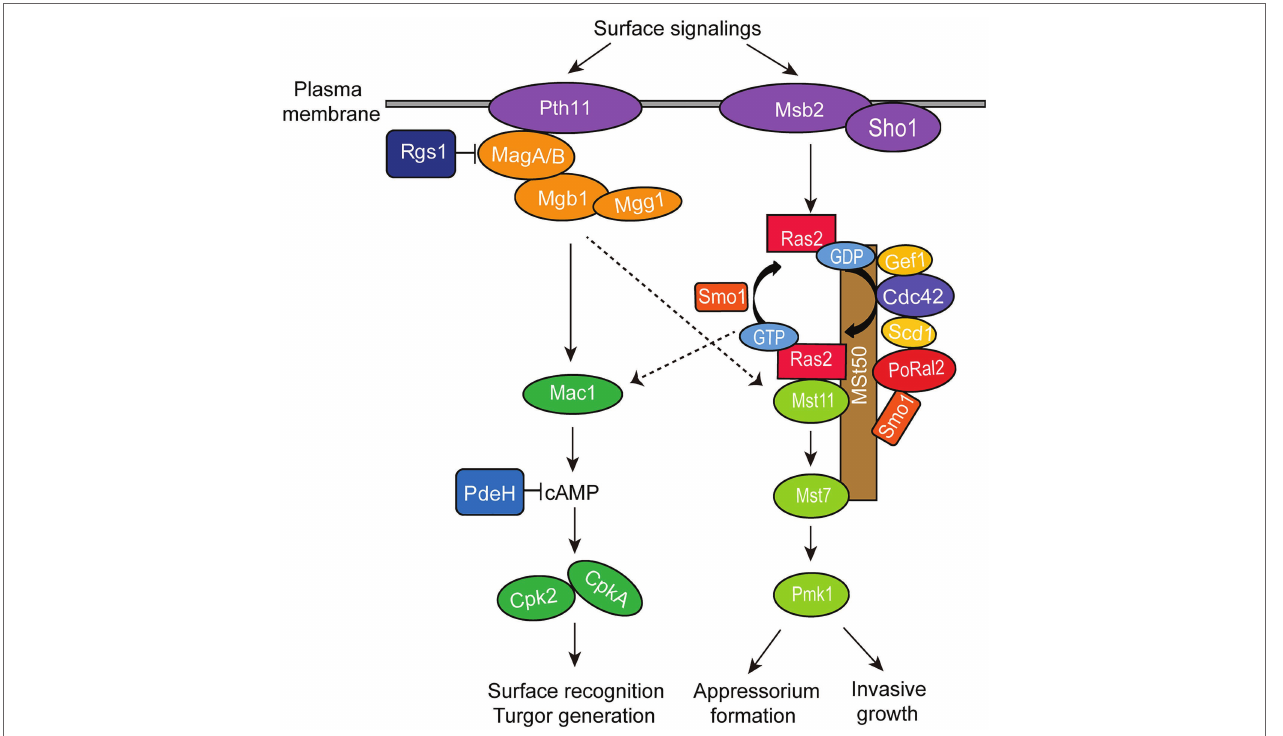
FIGURE 8 | Model for PoRal2 roles during surface signaling transduction and appressorium formation in P. oryzae . PoRal2 interacts with Smo1, Scd1, and Mst50 to regulate the activation of the Mst11-Mst7-Pmk1 MAPK pathway by Ras2, thereby controlling the appressorium formation and invasive growth